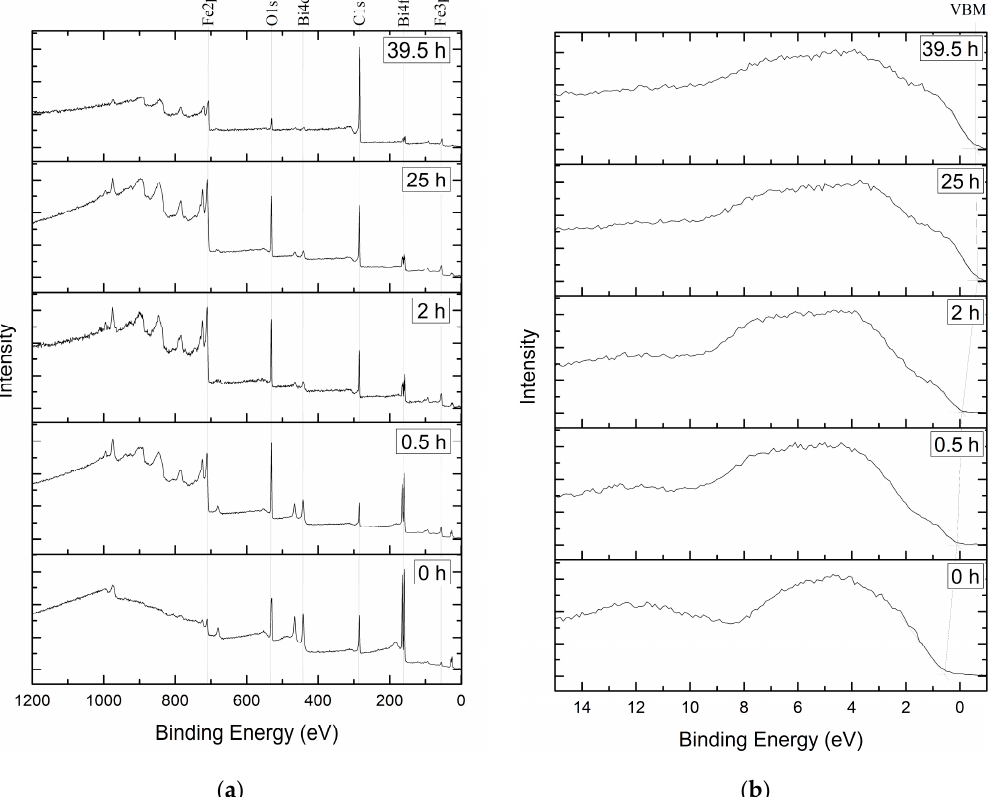
Figure 3. XPS survey spectra of the etched surface ( a ) and valence band spectra ( b ).